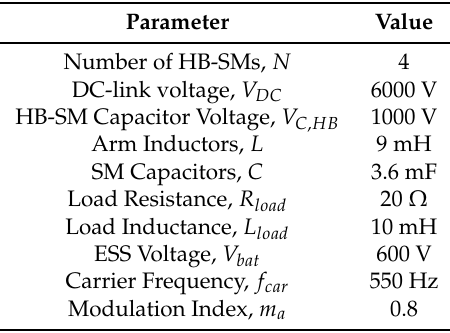
Table 2. Parameters of the